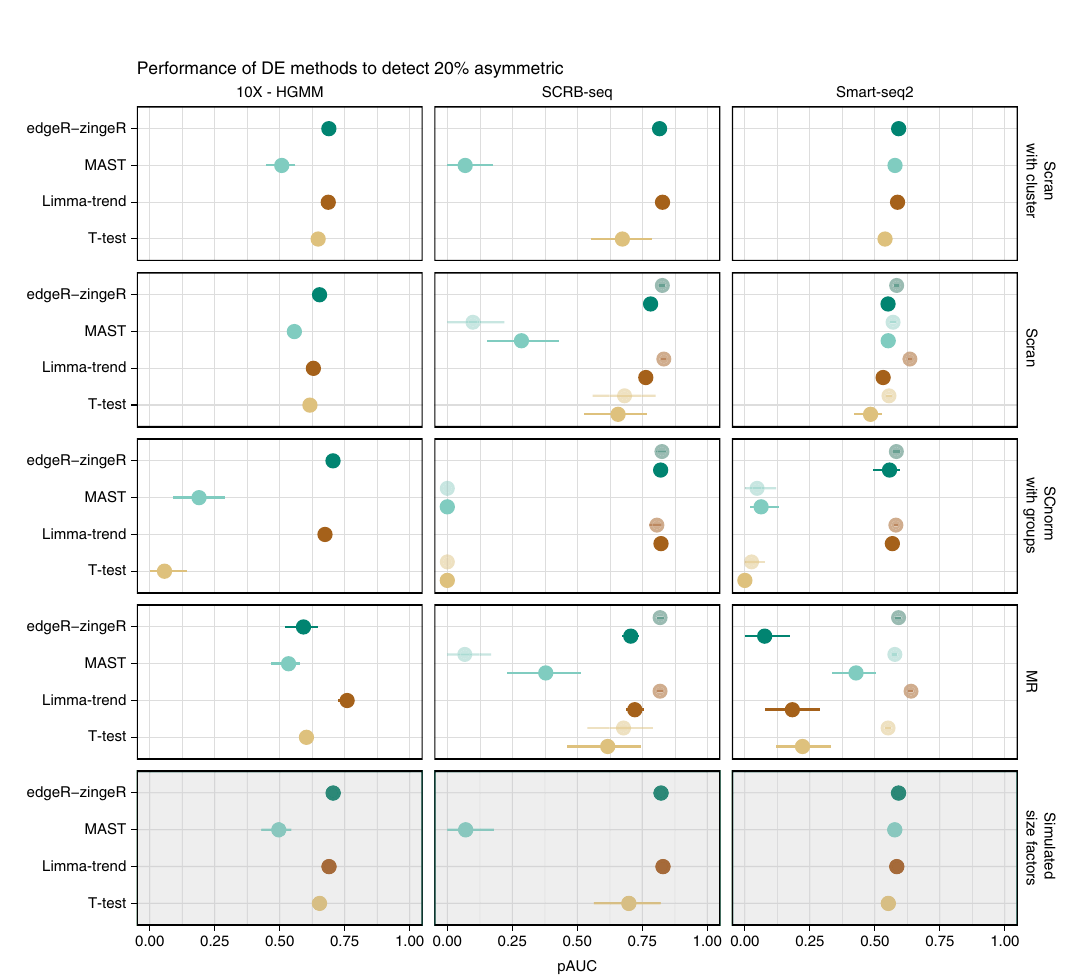
Fig. 3 Normalisation choices determines DE-analysis performance, not count preprocessing. The data in panels a – c are based on Smart-seq2 data, all panels are based on two groups of 384 cells, STAR alignment with GENCODE annotation was used for quanti fi cation. a The root mean squared error (RMSE) of estimated library size factors per normalisation method is plotted for 20% asymmetric DE-genes (see also Supplementary Fig. 11) (Box and whisker plot with centre line = median, bounds of box = 25th and 75th percentile, whiskers = 1.5 * interquartile range from the lower and upper bounds of the box). b The discriminatory ability determined by the partial area under the curve (mean pAUC ± s.d.) based on DE testing with limma-trend for normalisation without spike-ins per DE-pattern. The grey ribbon indicates the mean pAUC± s.d. given simulated size factors (see also Supplementary Figs. 13 – 15). c Using spike-ins for normalisation for 60% completely asymmetric DE-genes. d Effect of preprocessing the count matrix for 20% asymmetric DE-genes without spike-ins. Counts were either left asis ( ‘ none ’ ), fi ltered or imputed prior to normalisation. The derived scaling factors were then used for normalisation and DE testing was performed on raw counts using limma-trend (see also Supplementary Figs. 16 – 18). This procedure was applied to the full count matrix (circle) and to the count matrix downsampled to 10% of its original sequencing depth (triangular). Missing data points are due to failing